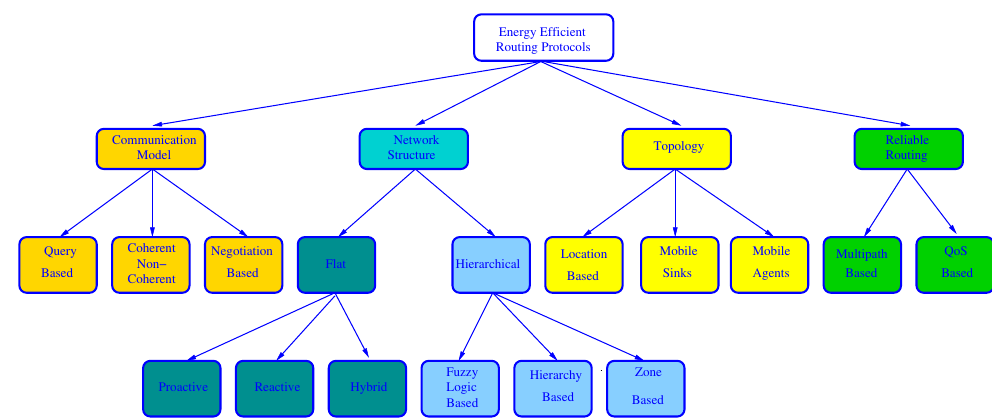
Figure 2. Classification of Energy-Efficient Routing Protocols used in